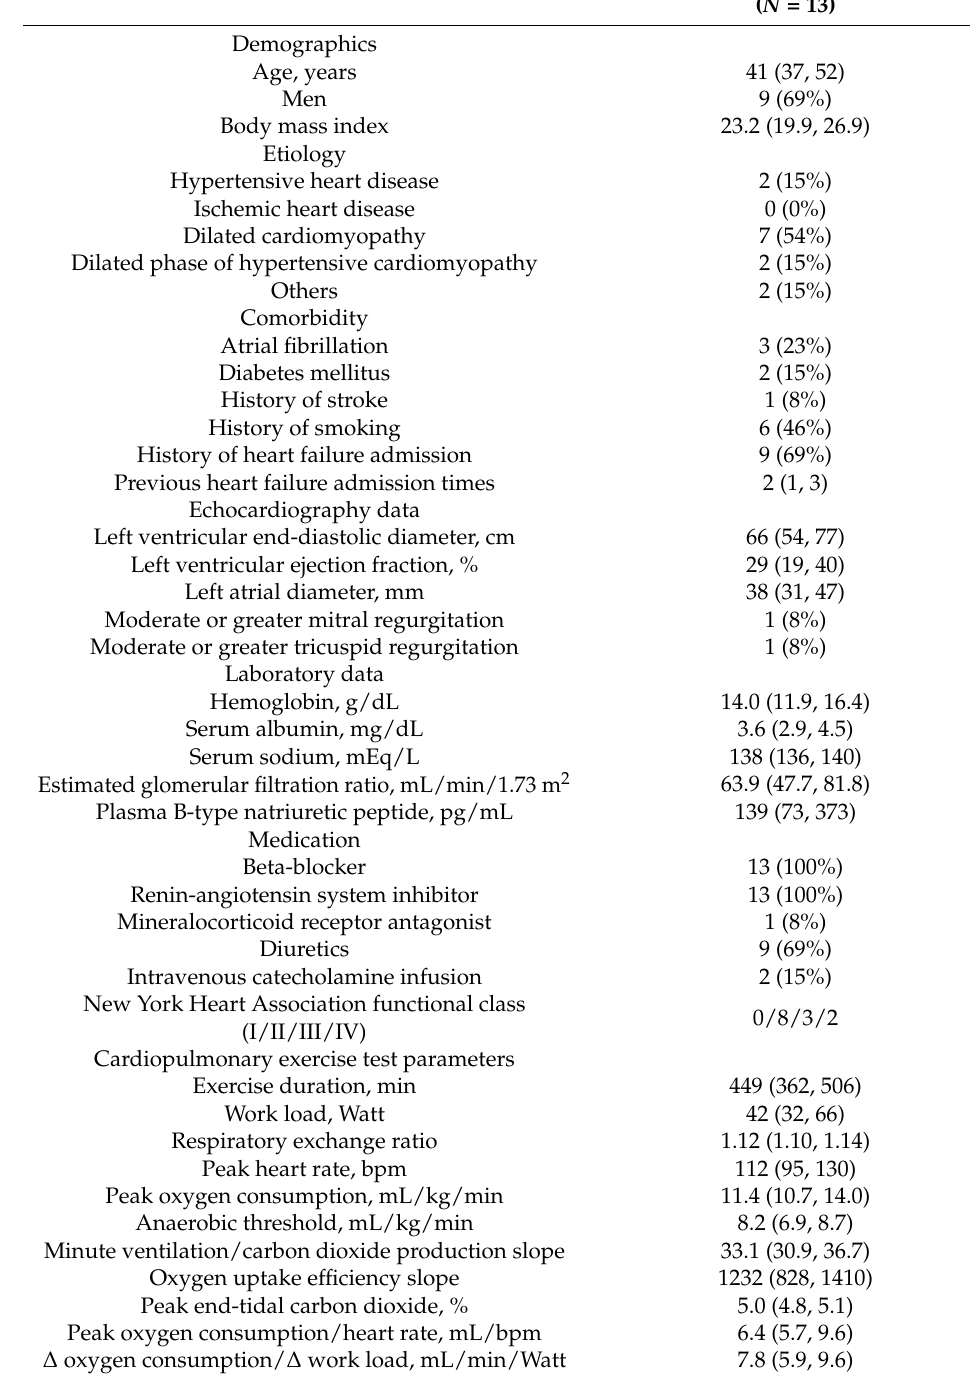
Table 1. Baseline